Question: Which visualization type does this figure use?
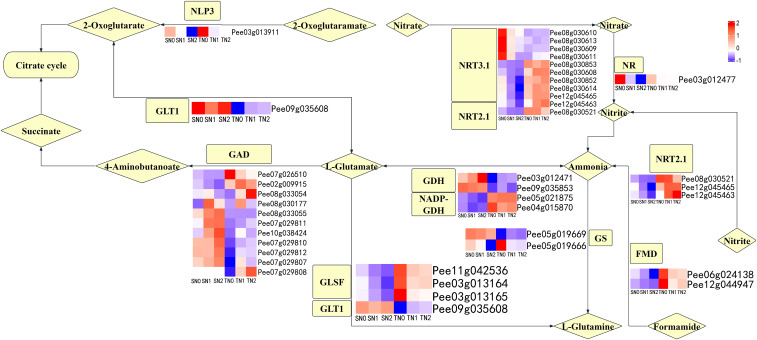
Answer: heatmap